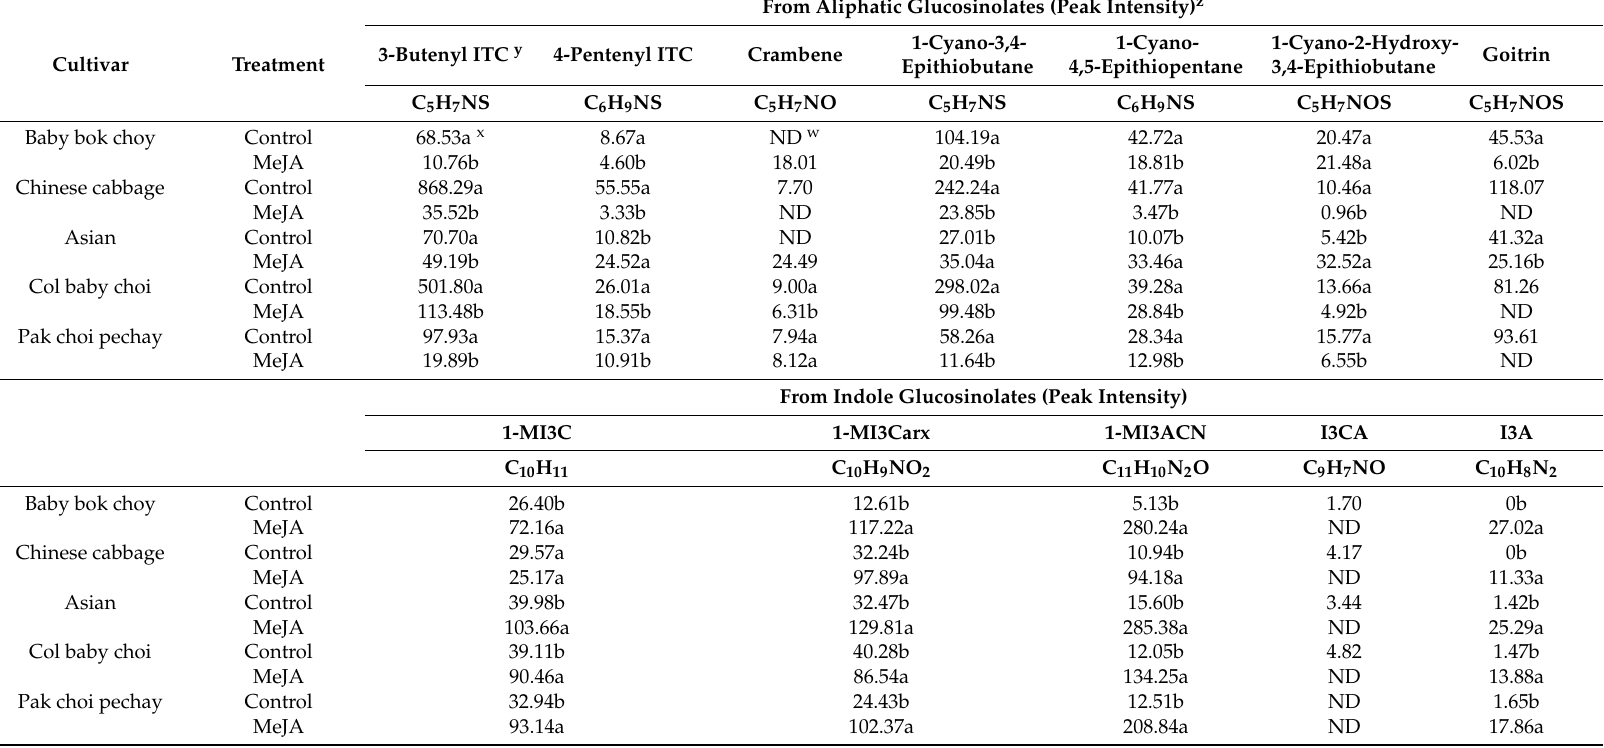
Table 1. GC-MS peak intensity changes in hydrolysis products by MeJA foliar spray treatment in pak